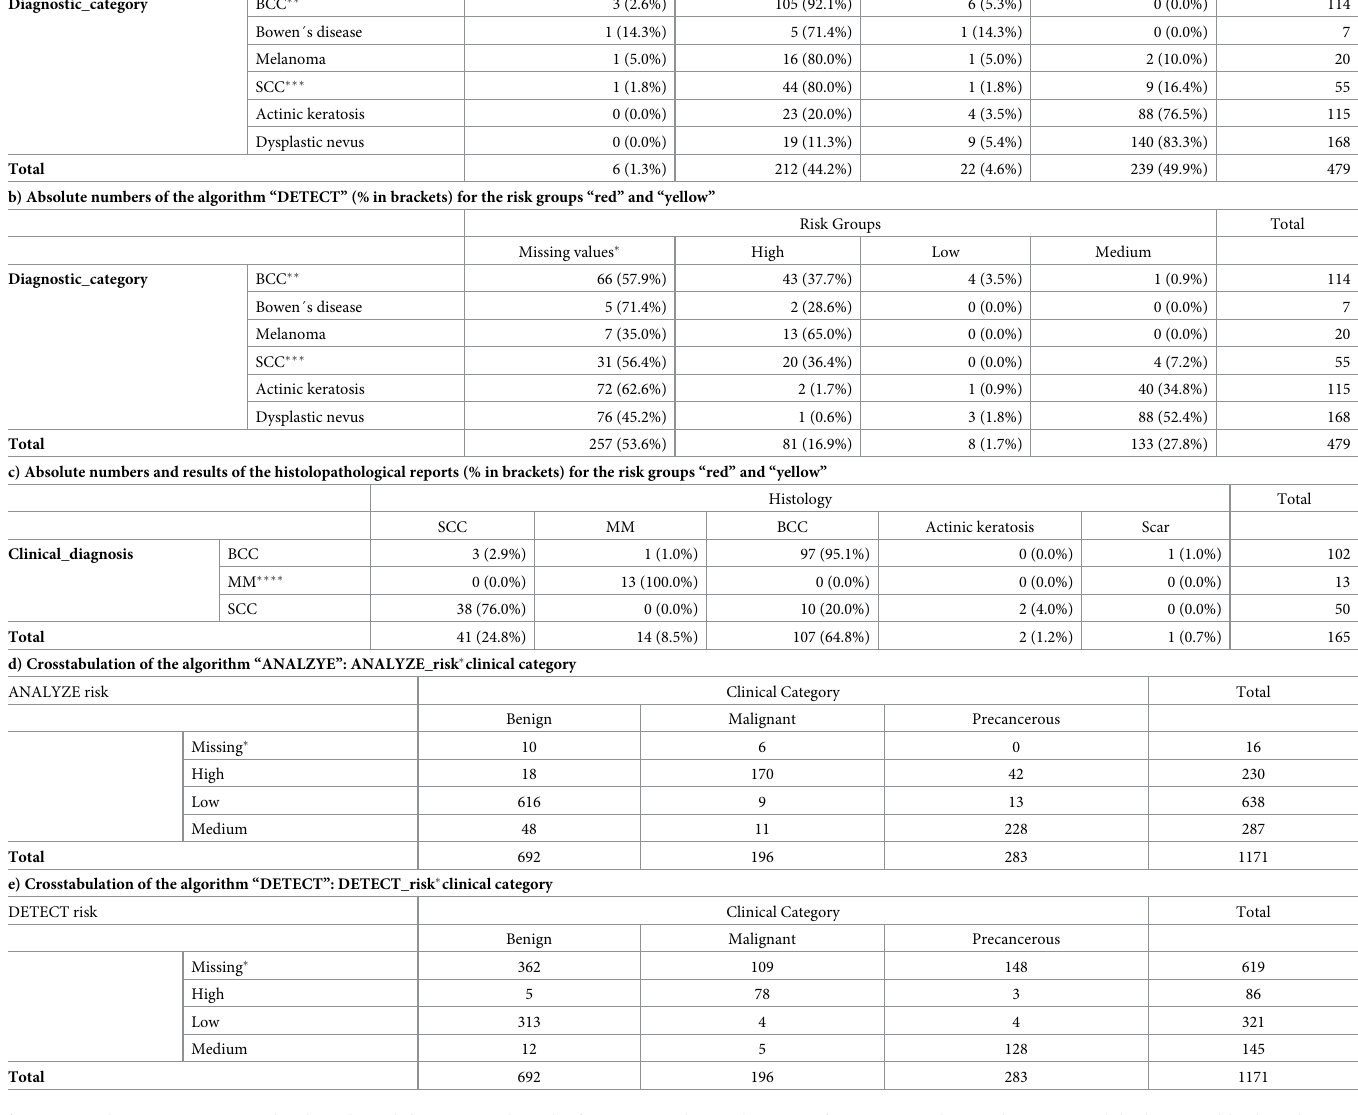
� Missing values: In some cases, the algorithms did not assess the risk of a respective lesion due to a software error. The numbers are much higher in Table 3b as the algorithm “detect” was developed later (details are described in the running text) ��